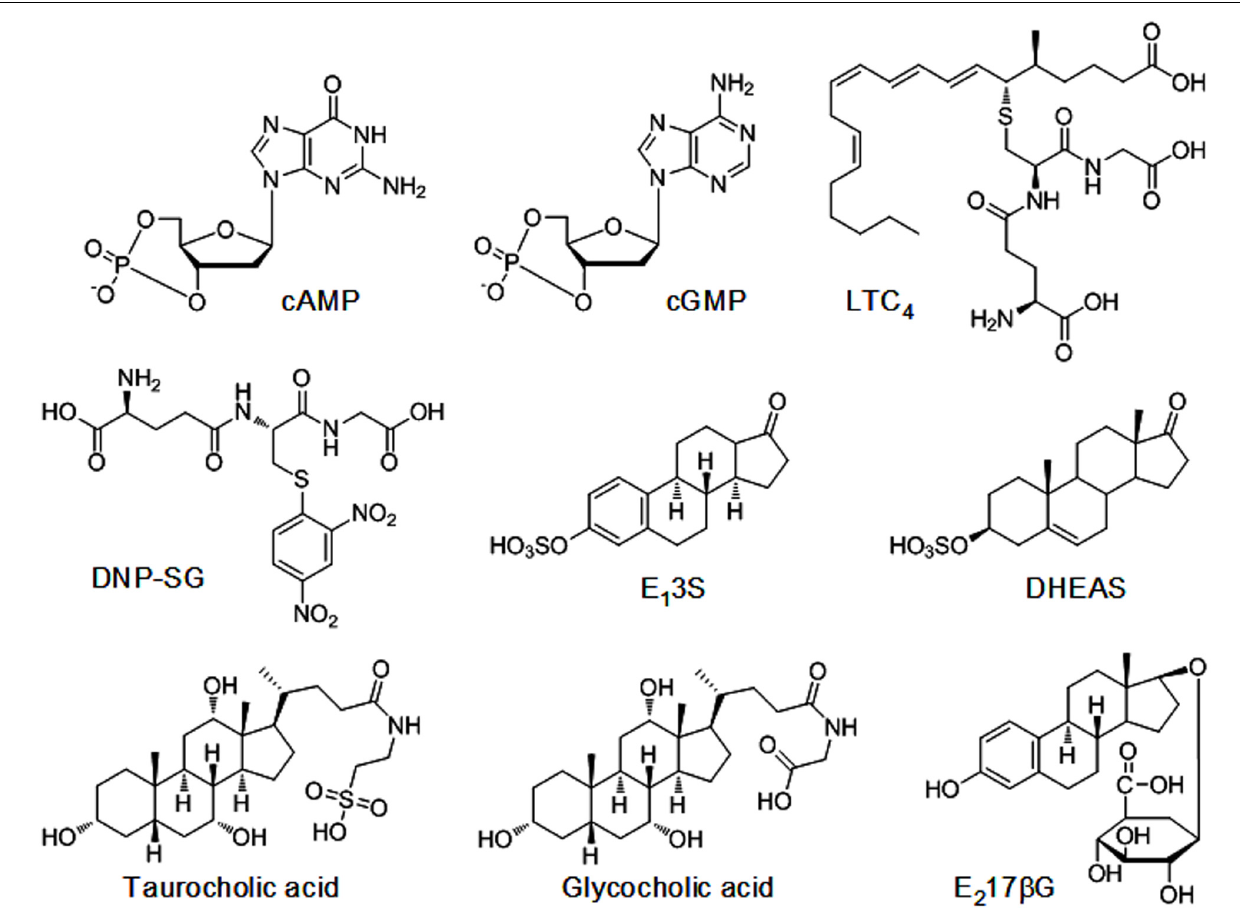
FIGUREA1 | Chemical structures ofABCC11 substrates. Cyclic adenosine monophosphate (cAMP), cyclic guanosine monophosphate (cGMP), leukotriene C 4 (LTC 4 ), S-(2,4-dinitrophenyl)-glutathione (DNP-SG), estrone 3-sulfate (E 1 3S), dehydroepiandrosterone 3-sulfate (DHEAS), and E 2 17 β G (estradiol 17- β - D -